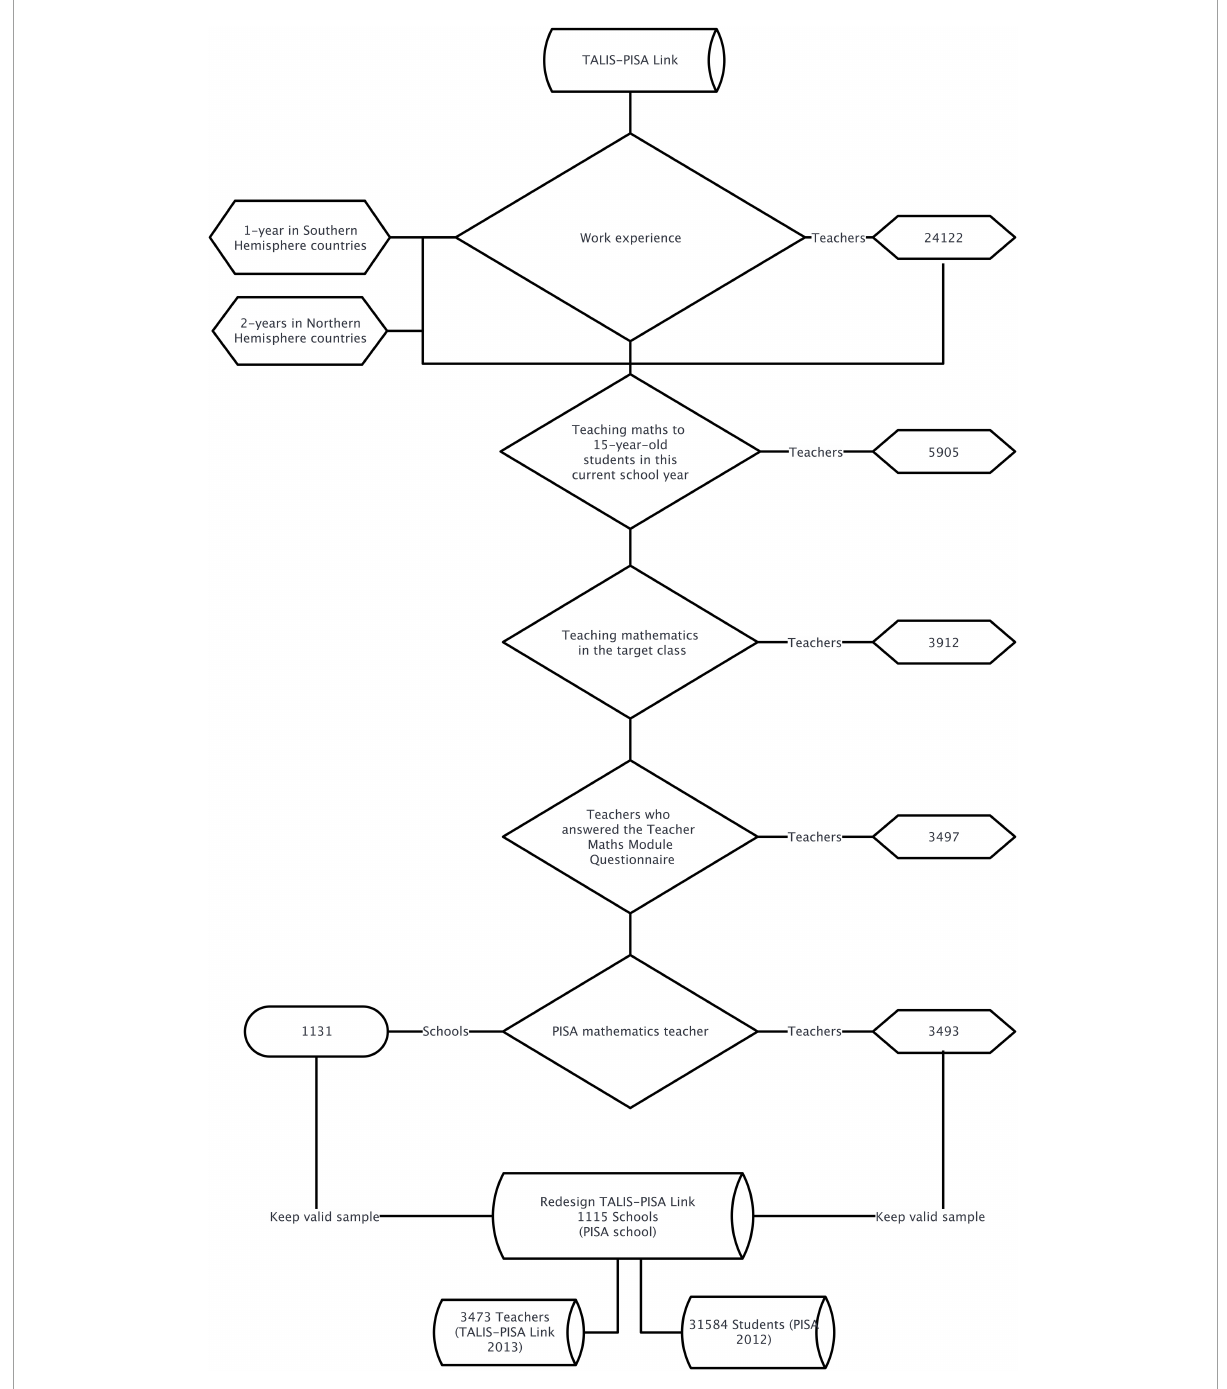
FIGURE4 The teacher sample selection criteria in the redesigned TALIS-PISA Link database